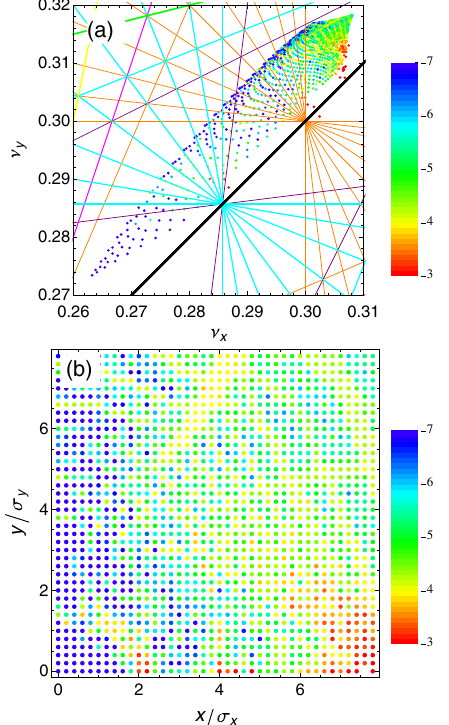
FIG. 5. Diffusion index for the crossing-angle collision with alternating horizontal and vertical crossing in two IPs. The top and bottom pictures show tune and amplitude spaces.